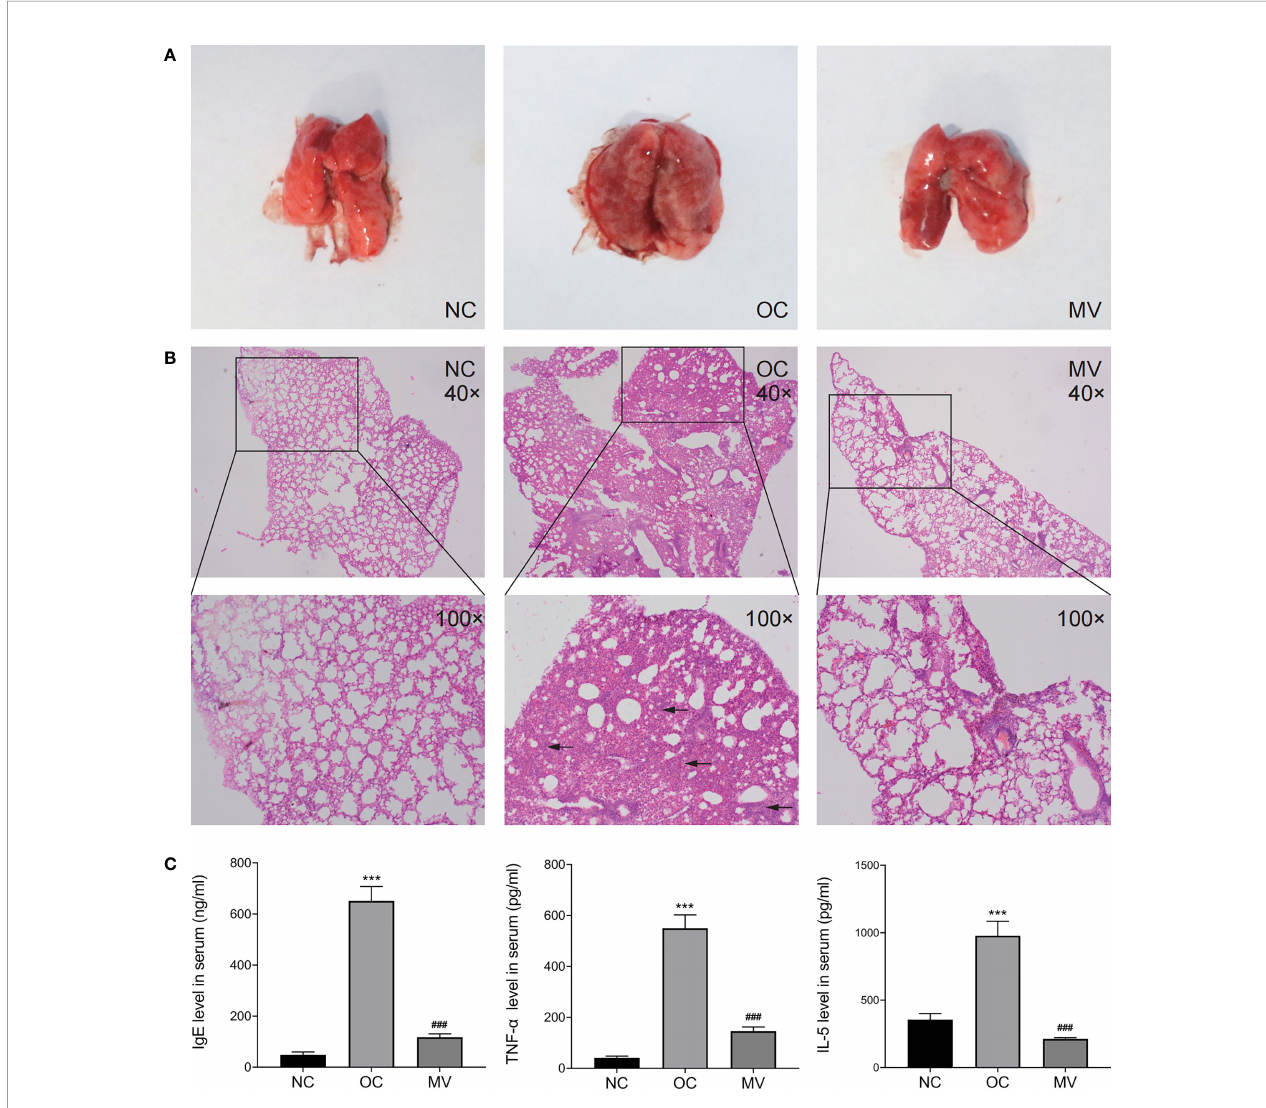
FIGURE 2 | (A) Representative histomorphological observation of lungs from different groups. (B) Hematoxylin and eosin-stained mouse lung sections from the normal control group (NC), the ovalbumin control group (OC), and the group treated with 50 mg/kg mogroside V (MV). The original magni fi cation was ×40 (upper panels). Inserts show magni fi ed regions at ×100 (lower panels). (C) Mogroside V treatment attenuates the production of Th1/Th2 cytokines as indicated by the levels of IgE, TNF- a , and IL-5 determined by ELISA kits. All values are mean ± SEM ( n = 3) by one-way ANOVA. *** P < 0.001 NC vs . OC group; ### P < 0.001 OC vs . MV